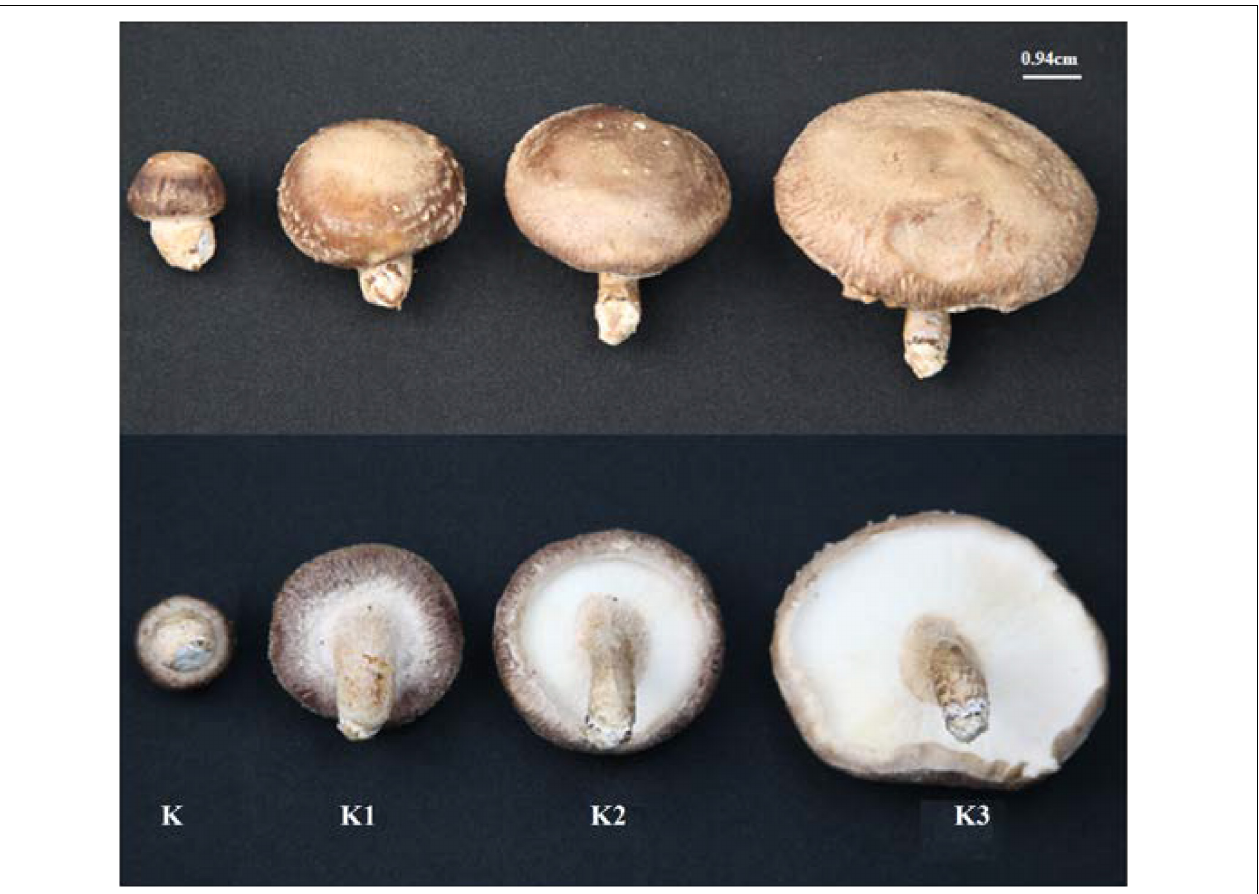
FIGURE 1 | Morphological characteristics of L. edodes fruiting bodies at different development stages. K represented button stage, the fruiting body was undifferentiated, and pileus diameter was 0.5–1.0 cm. K1 represented harvest stage, the veil formed, and pileus diameter was 2.8–3.3 cm. K2 represented mature stage, and the veil dehisced completely. K3 represented opening stage, and the pileus opened